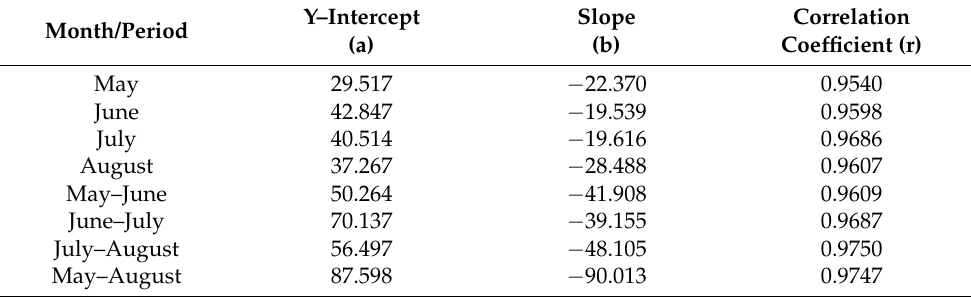
Figure 6. The linear relationship between the meteorological drought index and agricultural drought in the period of active plant growth and development (May–August) in the region of Bydgoszcz in 1961–2020. Table 6. Regression equations allowing determination of the agricultural drought index based on the SPI with correlation coefficients characterizing the strength of a linear